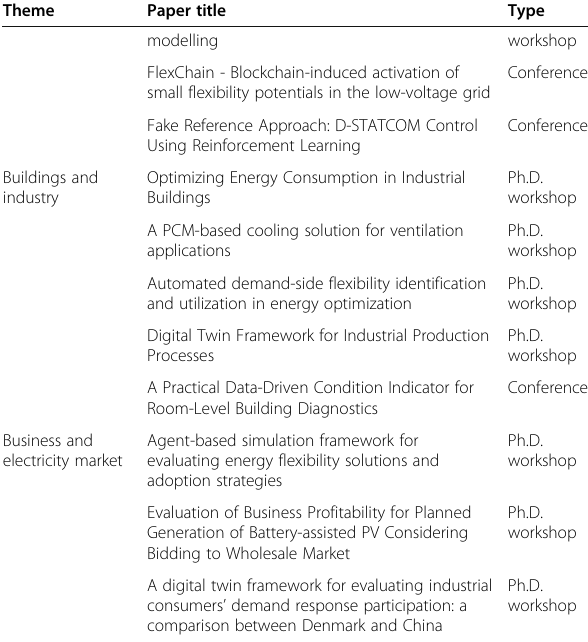
Table 1. Themes of the 13 poster abstracts from Energy Informatics. Academy (EI.A) Asia 2021